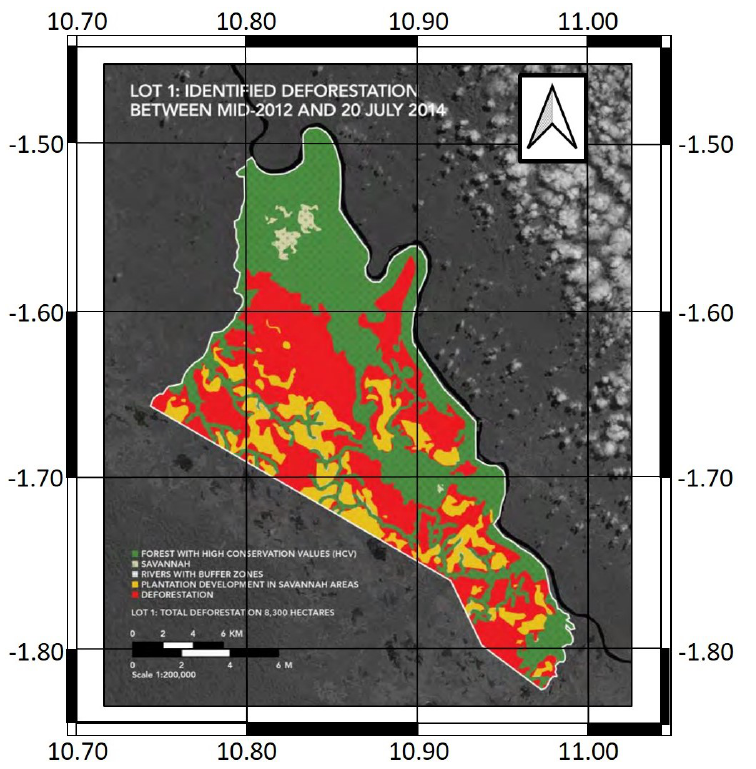
Figure 2. Reference map of the study site. Green, natural forest; Red, deforested area for oil palm plantations; Orange, savannah areas substituted by oil palm plantations; Light Green, savannah. Adapted (geographical coordinates included) and reproduced with the kind permission of Mighty Earth